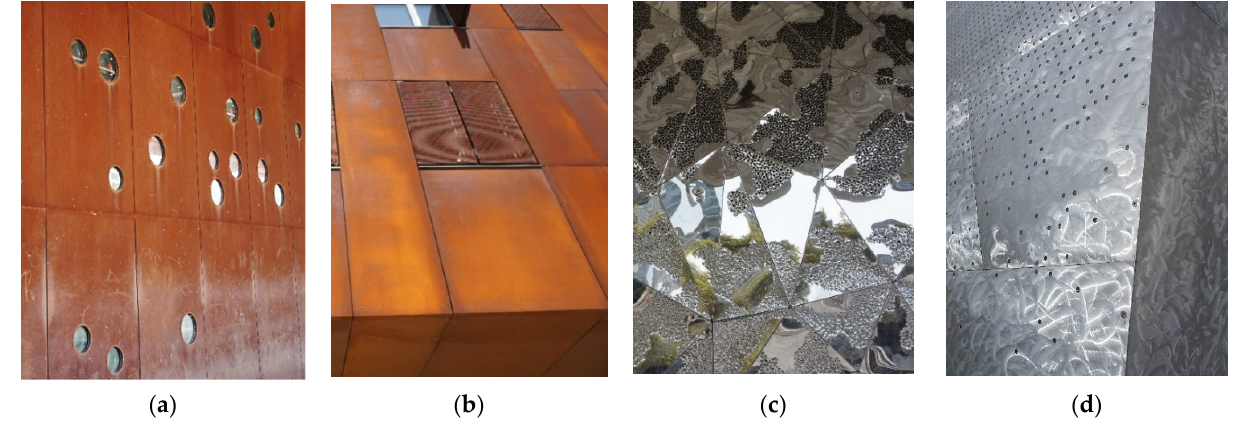
Figure 2. Applicationf ADAD concept in the flat composition of an enclosure; ( a ) Façade cladding in Corten steel sheeting, Centro de Convenciones de Barcelona, Barcelona, Spain, arch. Josep Lluis Mateo-MAP Arquitectos, 2004 (Photo by M. Celadyn, 2014); ( b ) Inner courtyard walls’ cladding with plane and perforated Corten sheeting, Teaching Center Vienna University of Economics and Business, Wien, BUSarchitektur ZT GmbH, 2013 (Photo by M. Celadyn); ( c ) Façade cladding in partially perforated and stamped stainless steel sheeting, Museu Blau, Barcelona, arch. Herzog and de Meuron, 2011 (Photo by M. Celadyn); ( d ) “The wings” sculptures fabricated with panels of brushed aluminium, EXPO Mediolan, arch. D. Libeskind, 2015 (Photo by M. Celadyn). Table 1 identifies the main attributes of the flat composition scheme with applied these variables on the formal appearance of the building enclosure. Table 1. Typology of flat composition in ADAD